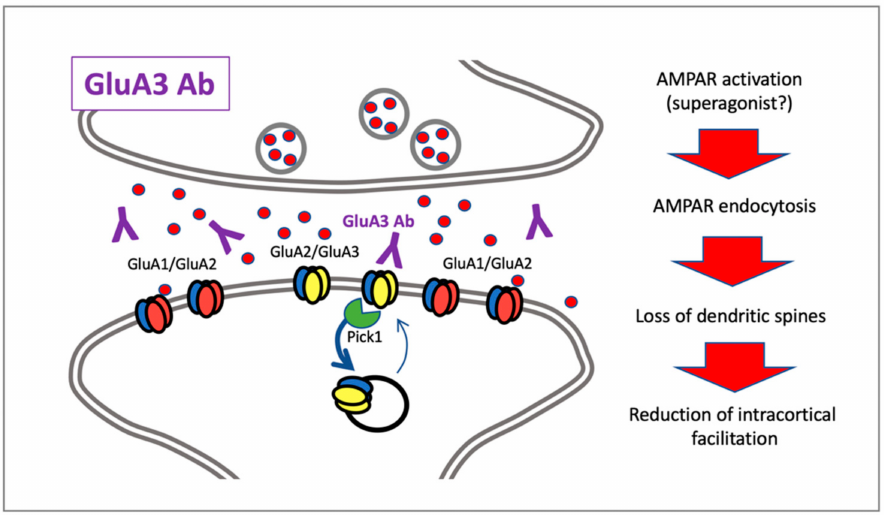
Figure 2. Graphic representation of molecular and cellular mechanisms triggered by anti-GluA3